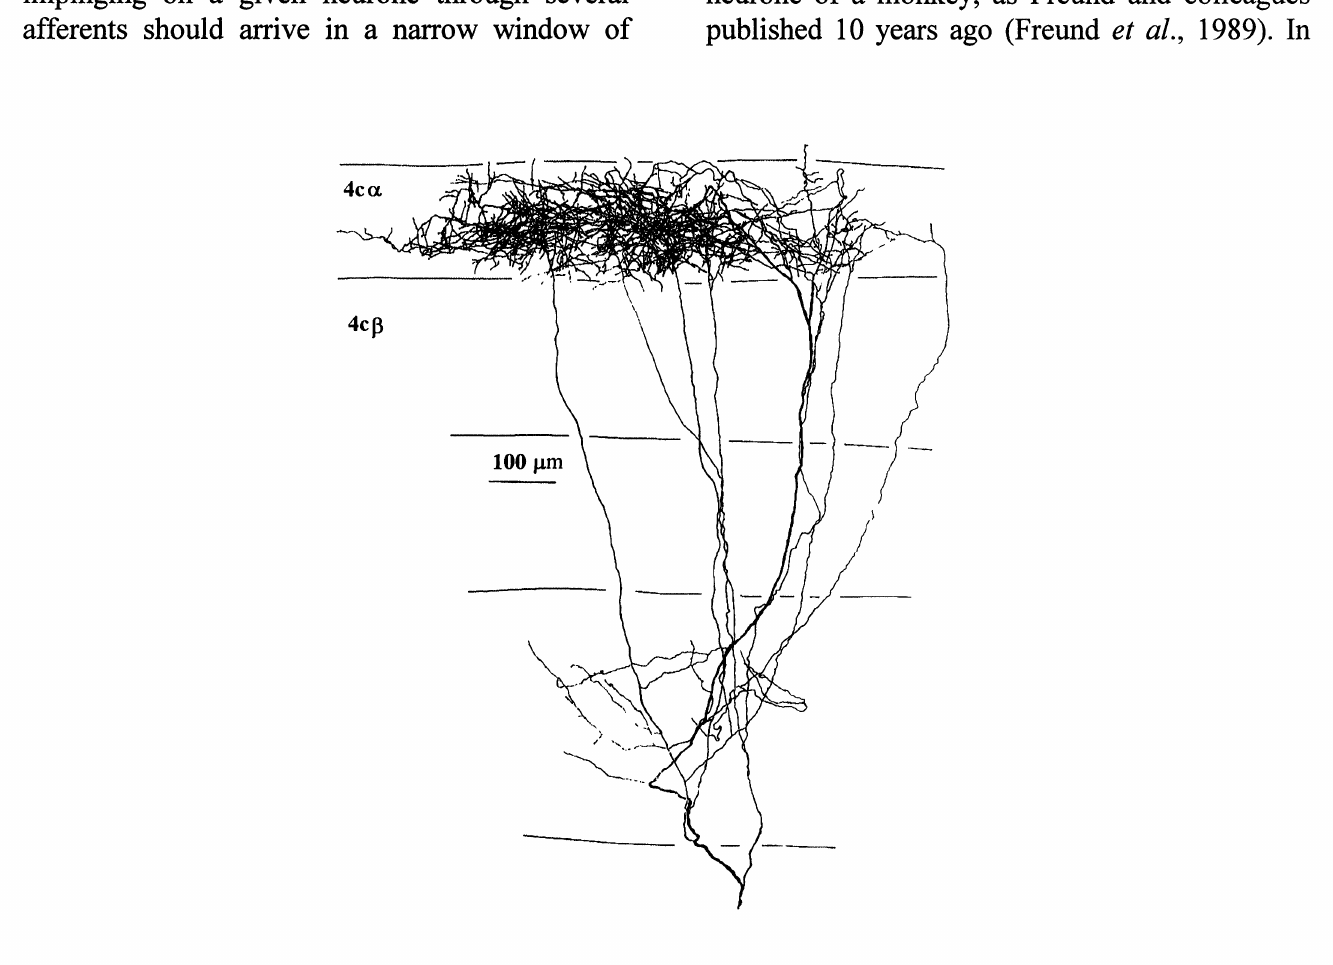
Fig. 5: Camera lucida reconstruction of a magnocellular axon in the monkey striate cortex. It had an off-center receptive field. The center size was 0.5 in diameter at a position of azimuth 7.5 ipsilateral eye and responded well to low-contrast, broad-band stimuli. The terminal arbor is restricted to the upper part of layer 4C; only a few collaterals terminate in layer 6. A top view (from the pia) shows that the boutons form three distinct, unevenly populated, clumps (not shown). Scale: 100 tm. (From Freund et al., 1989). (C) 1989 J. Comp. Neurol. Reprinted by permission of Wiley-Liss, Inc., a division of John Wiley & Sons,